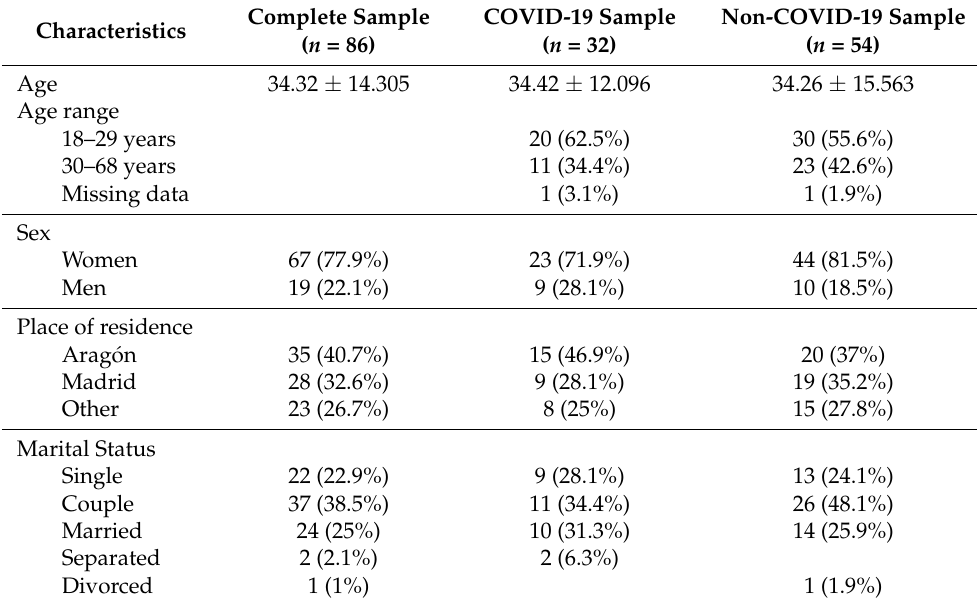
Table 1. Socio-demographic characteristics of the sample ( n =